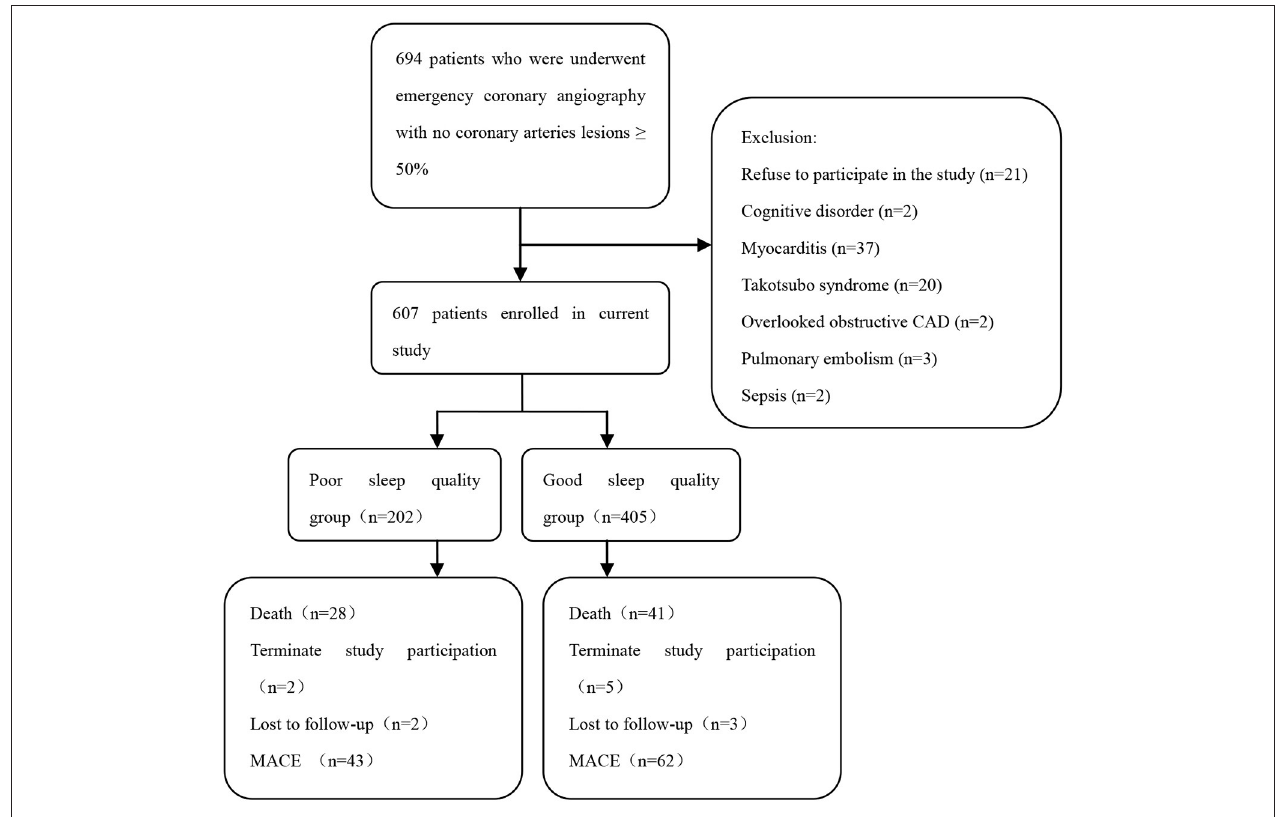
FIGURE 1 | Flowchart of the selection process and dropouts of current